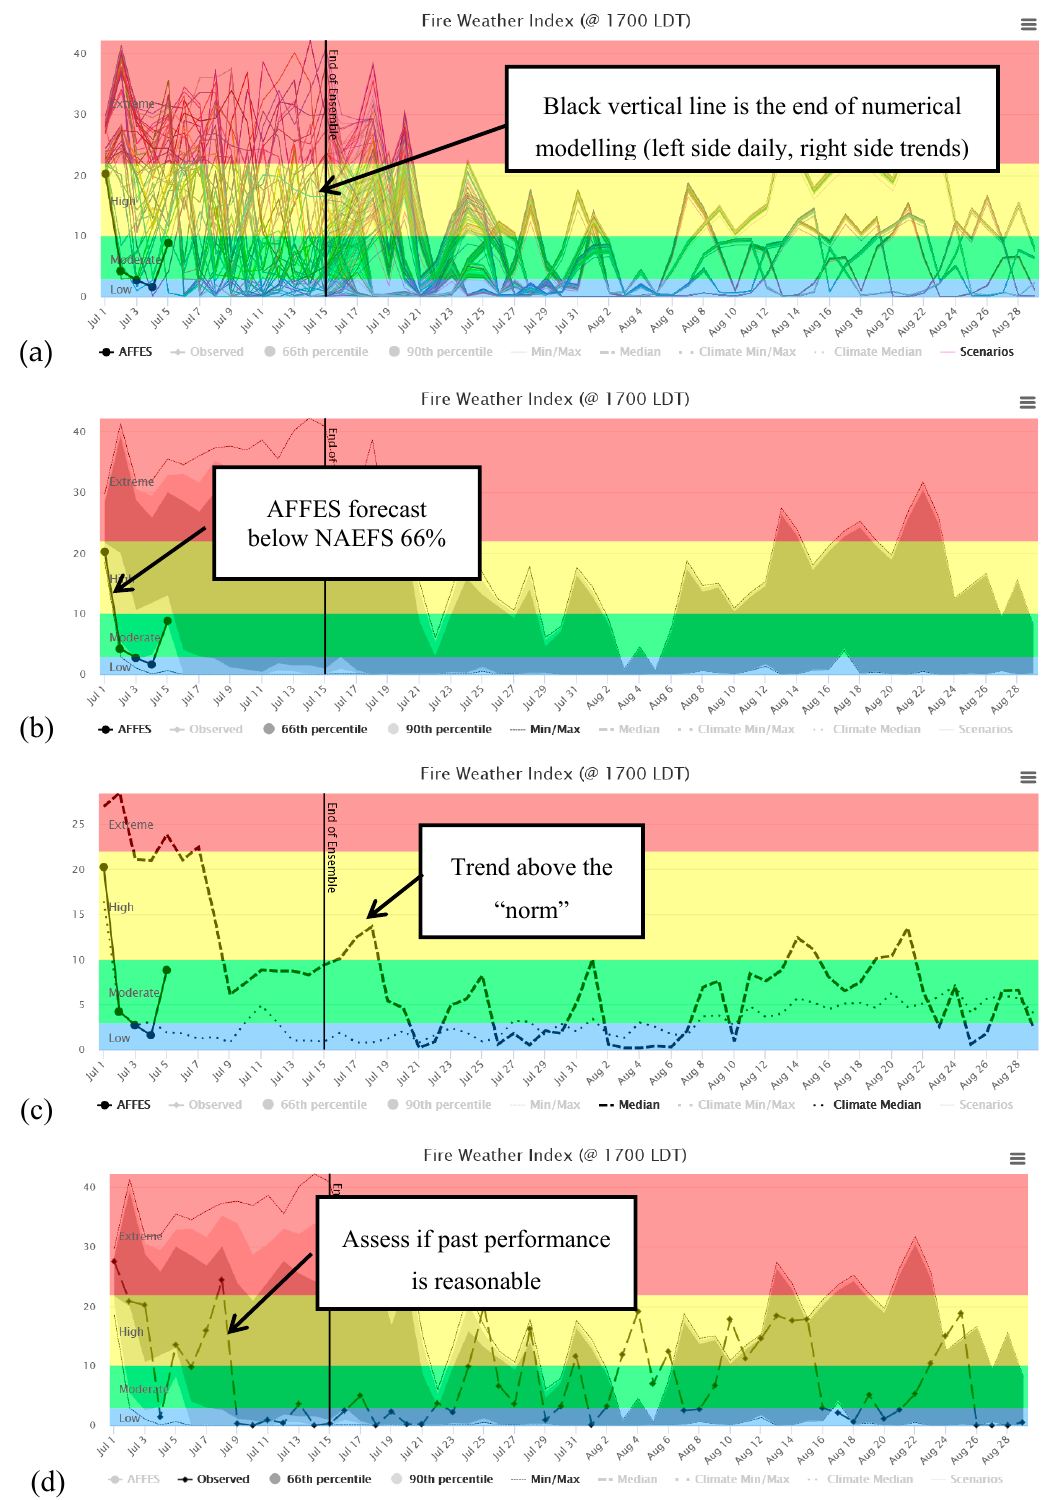
Figure 8. Illustrations of a location’s 30-day forecast for FWI (Fire Weather Index) showing: ( a ) Individual scenarios; ( b ) prediction intervals; ( c ) medians for our forecast and for climatology as a forecast; ( d ) actual observations and the forecast for the period.